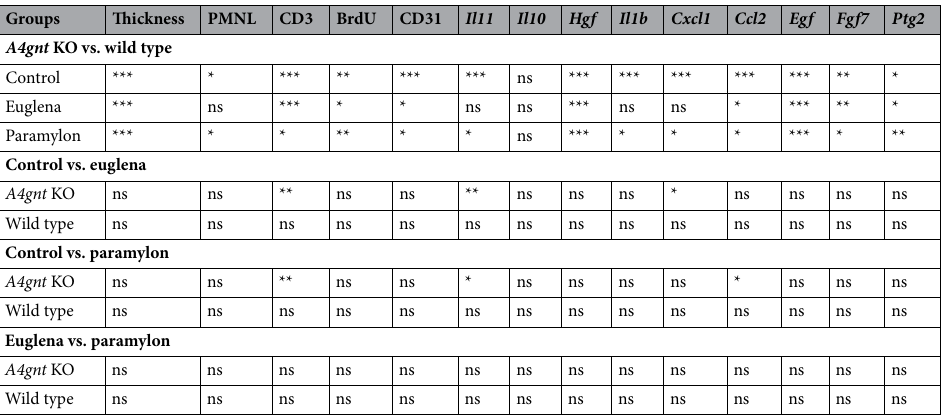
Table 1. Summary of statistical analysis. Tukey’s honest significance test using R software ver. 3.6.2 28 was used to analyze the differences and measure the significance. *** P value < 0.001, ** P value < 0.01, * P value < 0.05, ns P value >